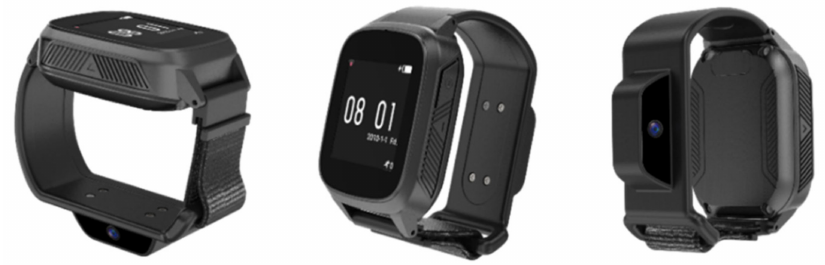
Figure 4. Camera module embedded in smartwatch for medication behavior monitoring.